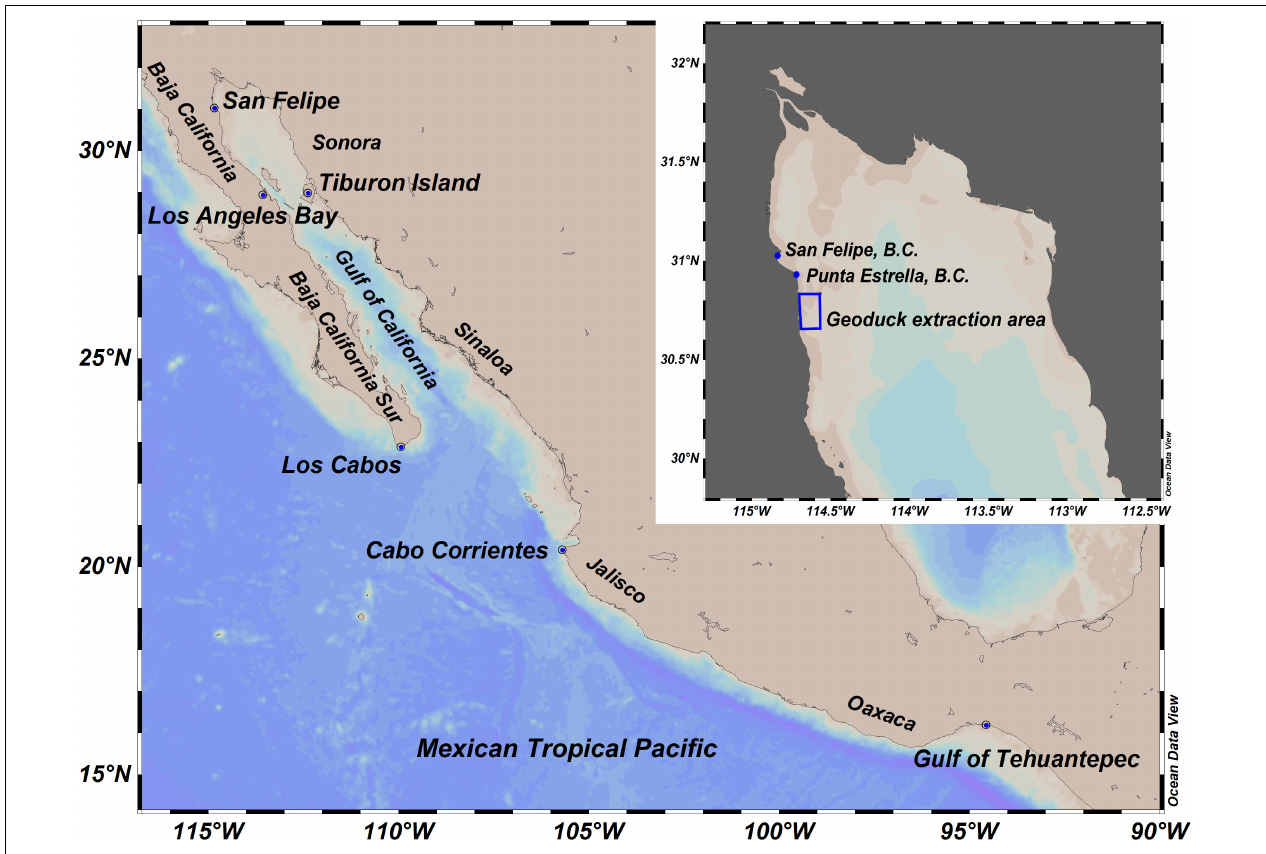
FIGURE 2 | Gulf of California and Mexican Tropical Pacific where outbreaks of paralytic shellfish toxins have occurred. The northern part of the Gulf of California and the location of Atenea en el Mar company federal approved area for harvesting of Panopea globosa in San Felipe, BC, are presented in the inset of the